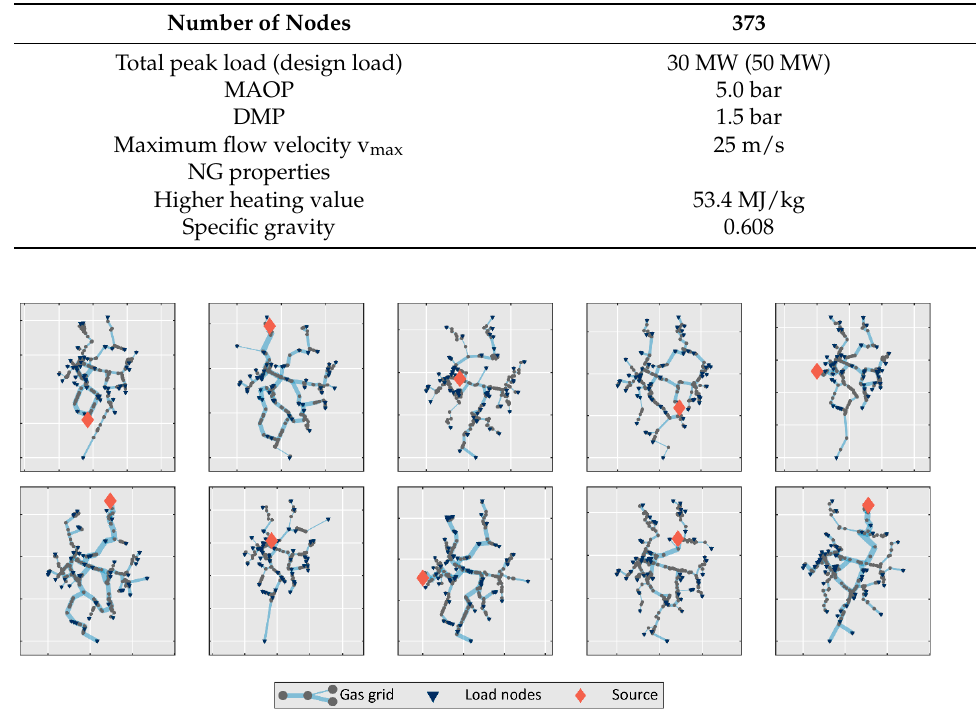
Table 1. Inputs adopted for the creation of synthetic networks and their technical sizing.